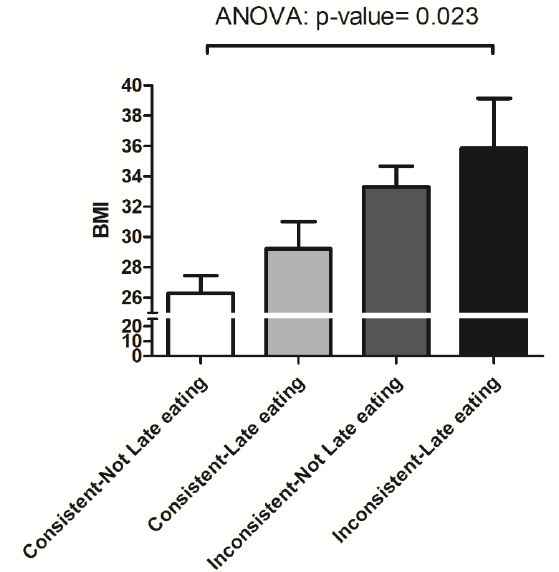
Figure 2: Subrgroup analysis of the time of eating habits. Mean +